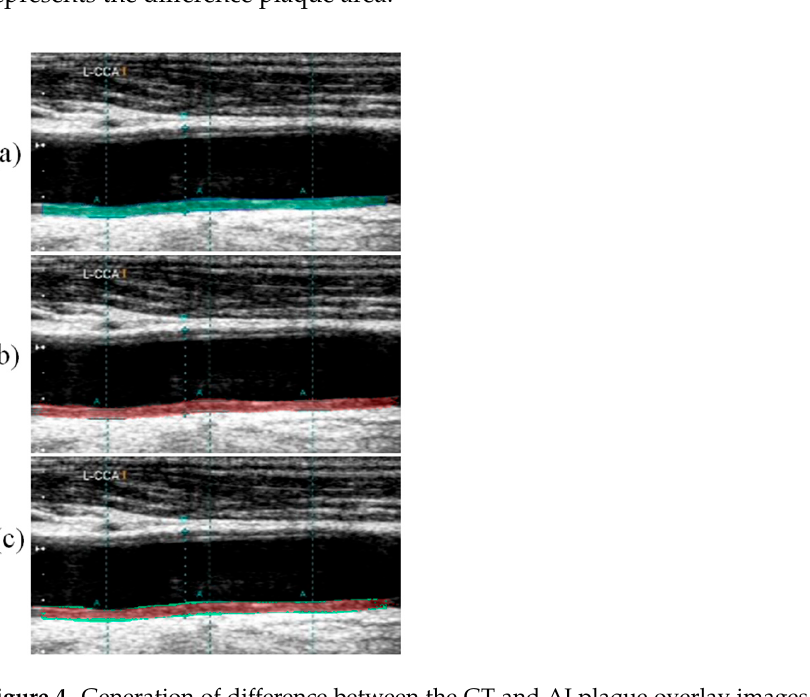
Figure 4. Generation of difference between the GT and AI plaque overlay images. ( a ) GT plaque overlay ( b ) AI-estimated plaque overlay ( c ) Difference between GT and AI plaque overlay image. Figure 5 below shows the absolute difference image of the UNet model output (red) and GT mask overlay on the grayscale image (green).